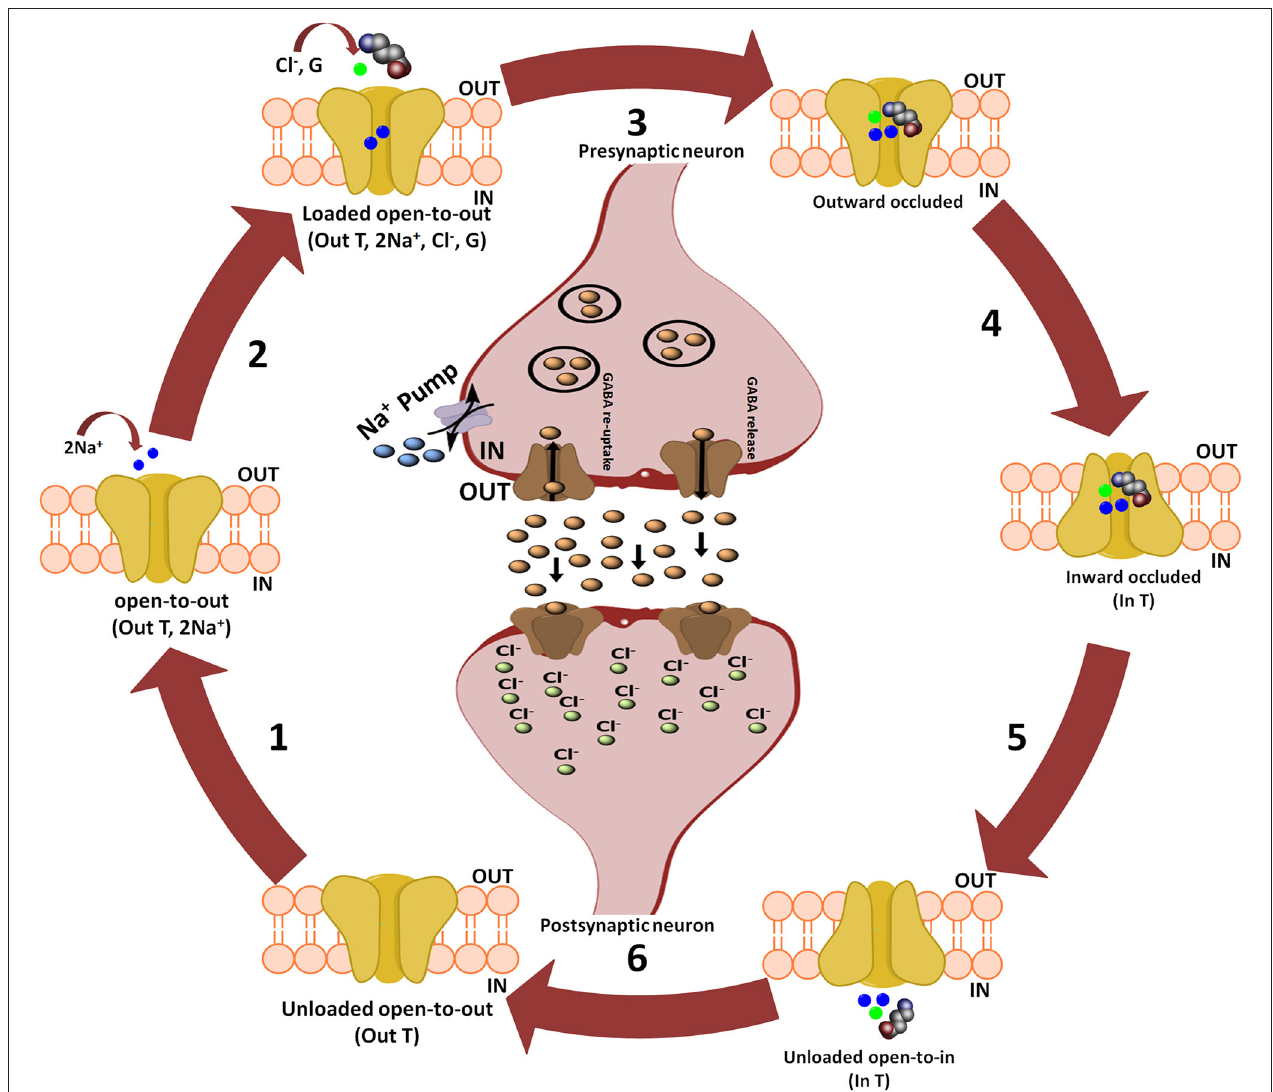
FIGURE 2 | Translocation cycle of GAT1. Steps 1–4 of translocation cycle represent the open-to-out conformation of hGAT1 which involves the co-transport of two Na + ions along with a Cl − ion and GABA (also known as forward mode of reaction). In forward mode, net influx of two Na + ions through GAT1 results in the increased concentration of Na + ions in the cytoplasm. To maintain the intracellular Na + ions concentration, Na + pump present on the presynaptic neuronal membrane effluxes the Na + ions into synaptic cleft to maintain the concentration gradient. Step 5 represents open-to-in conformation of hGAT1 (also known as reverse mode of reaction). In reverse mode functioning of Na + pump is opposite to that of the forward mode. In step 6, the hGAT1 becomes empty again to begin a new